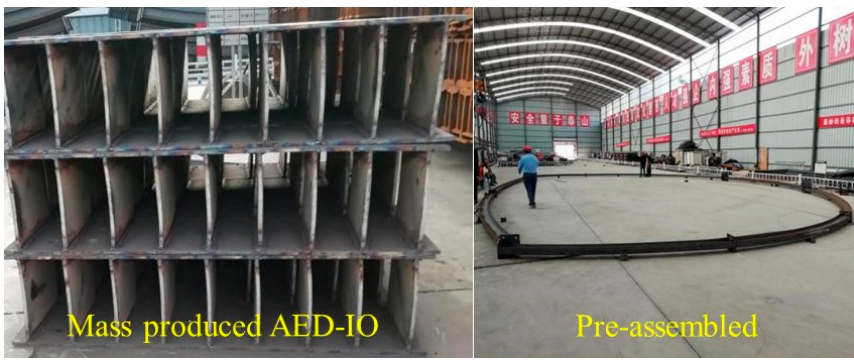
Figure 16. AED-IO production and pre-assembly. The AED-IOs were arranged at 22.5° of the steel arch’s left and right arch waists. The actual installation is shown in Figure 17.